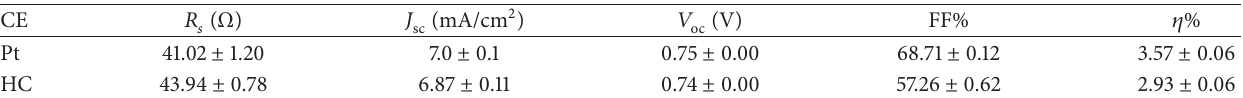
Table 1: Photovoltaic parameters of the cells shown in Figure 6. The errors are the SD values calculated from three measurements of three different devices for each film.